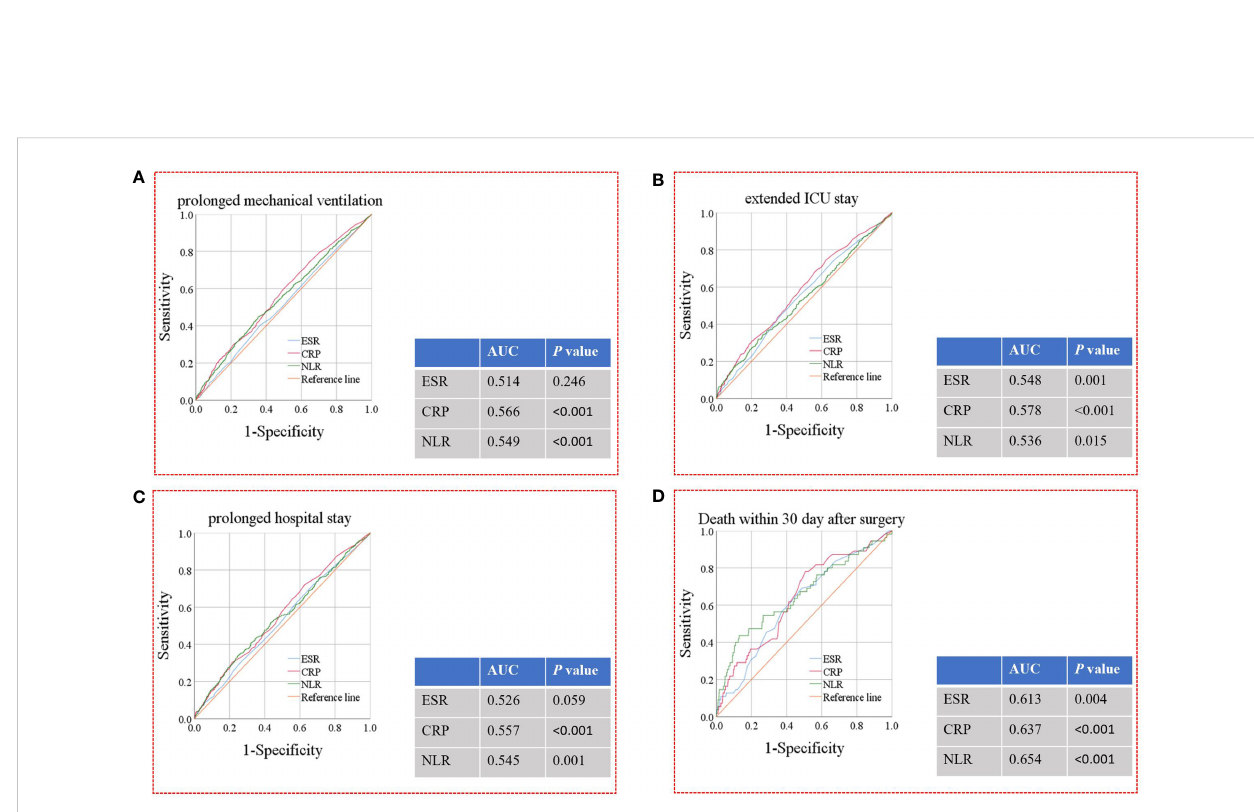
FIGURE 5 ROC analysis for ESR, CRP levels and NLR for the prediction of prolonged mechanical ventilation (A) , extended ICU stay (B) , prolonged hospital stay (C) , and death within 30 days after surgery (D) . ROC, receiver operating characteristic; ESR, erythrocyte sedimentation rate; CRP, Creactive protein; NLR, neutrophil-to-lymphocyte ratio; ICU, intensive care unit; AUC, area under the